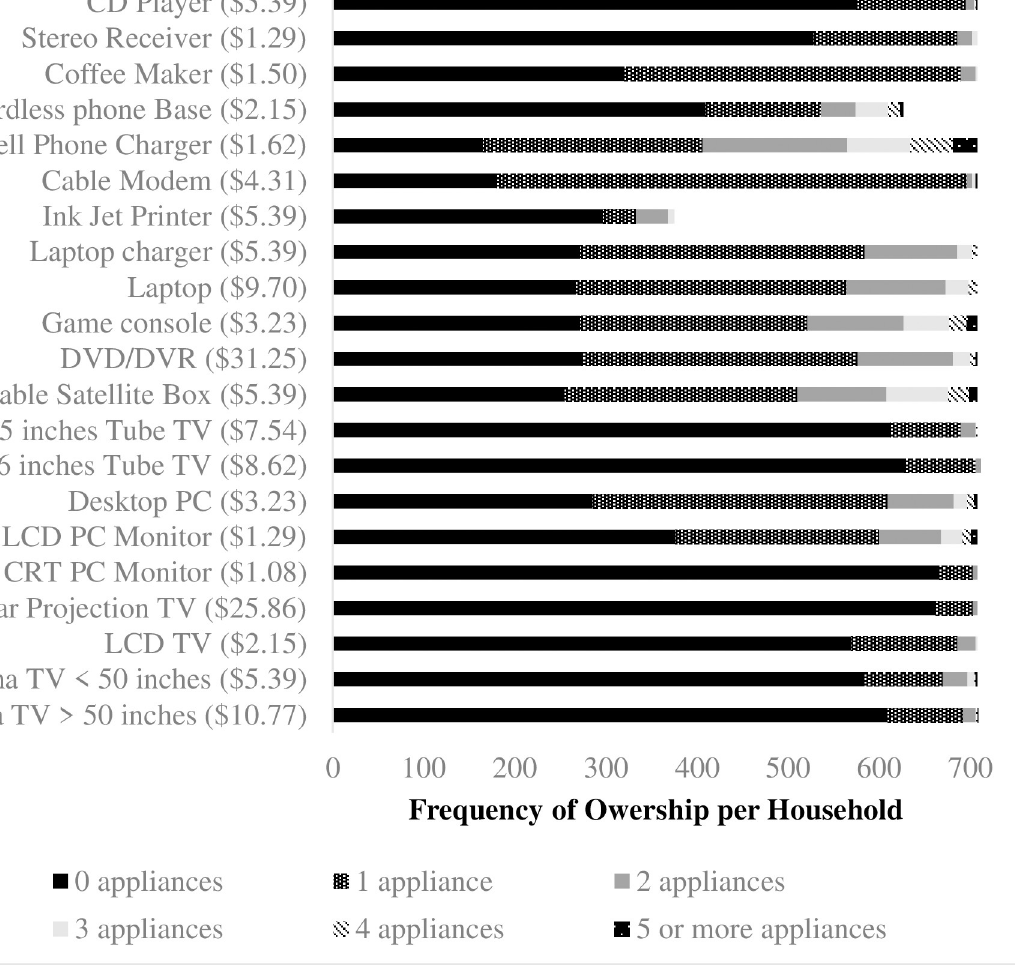
Fig 1. Frequency of ownership of appliances that consume standby power per